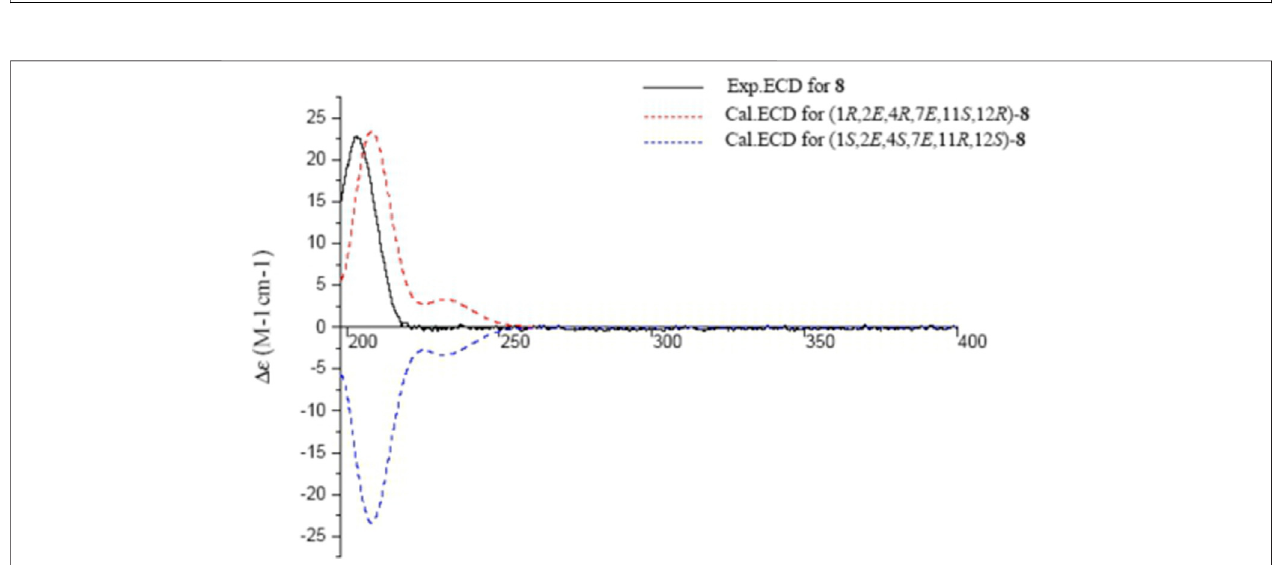
FIGURE8| Experimental and calculatedECDspectraof 7 and its enantiomer(red and bluecalculatedat the B3LYP/6 – 311++G (2d,p)//B3LYP/6 – 31+G (d, p )level in CH 3 OH; black, experimental in CH 3 OH).